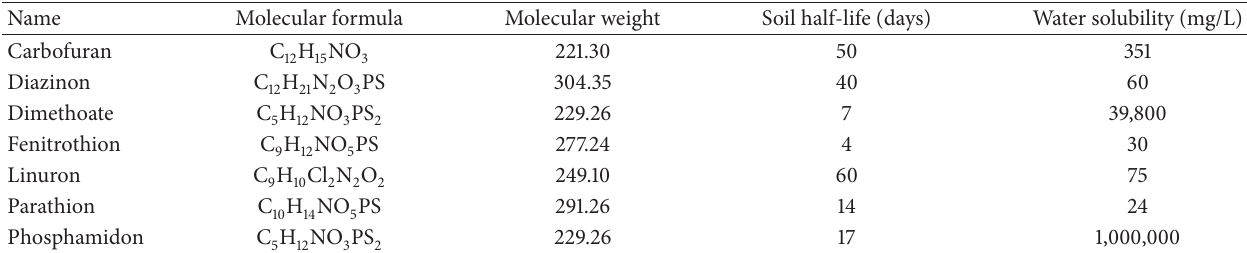
Table 4: Physiochemical properties of the investigated pesticides [37,